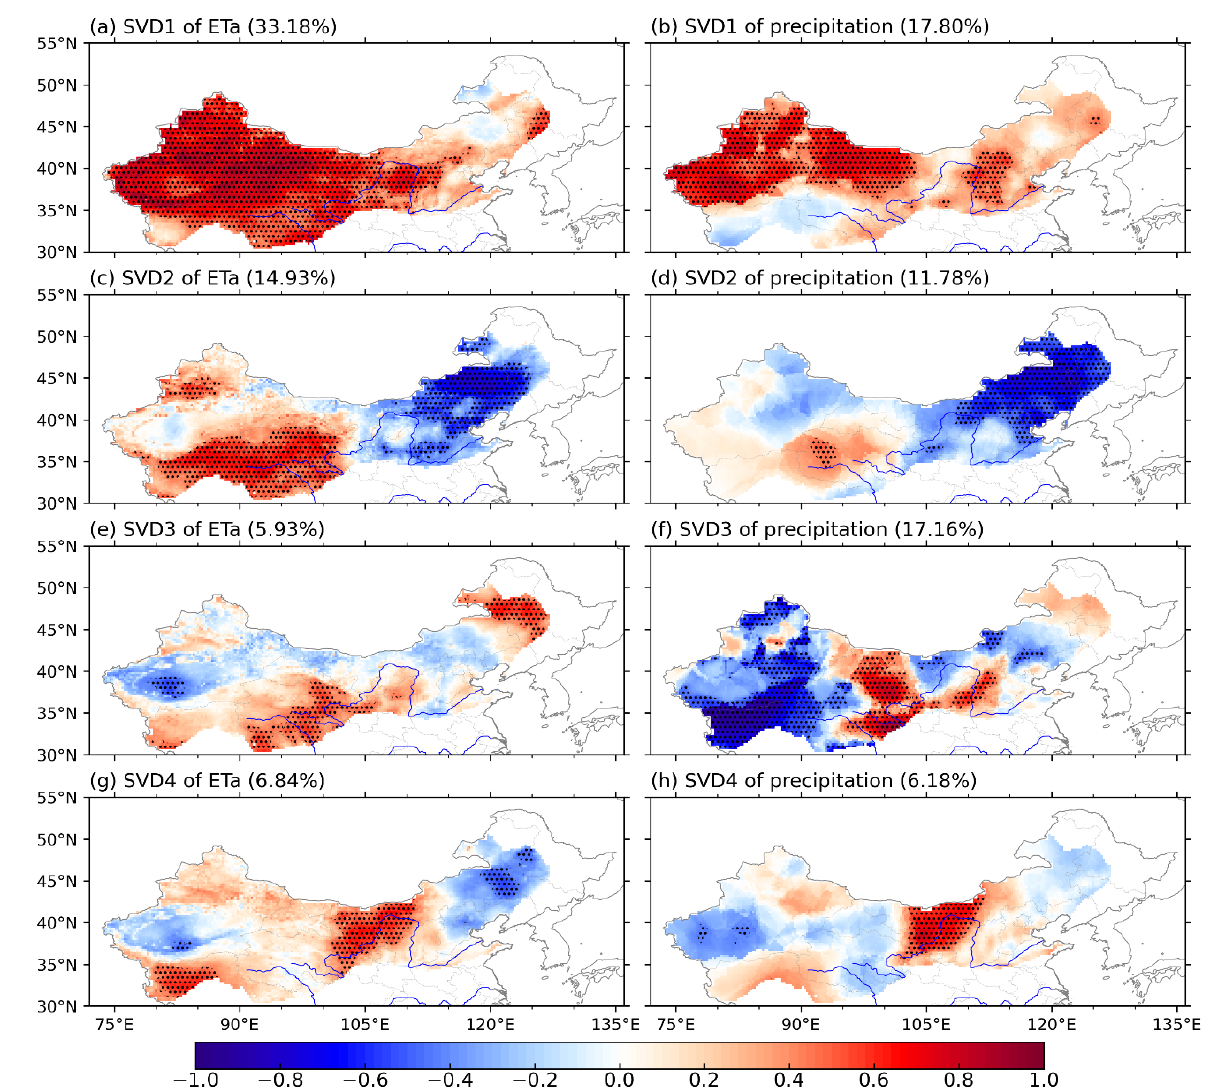
Figure 6 . Homogeneous correlation patterns for the first four leading SVD modes of ETa and precipitation in northern China during 1982–2017. The dots denote values exceeding the 95% confidence level.